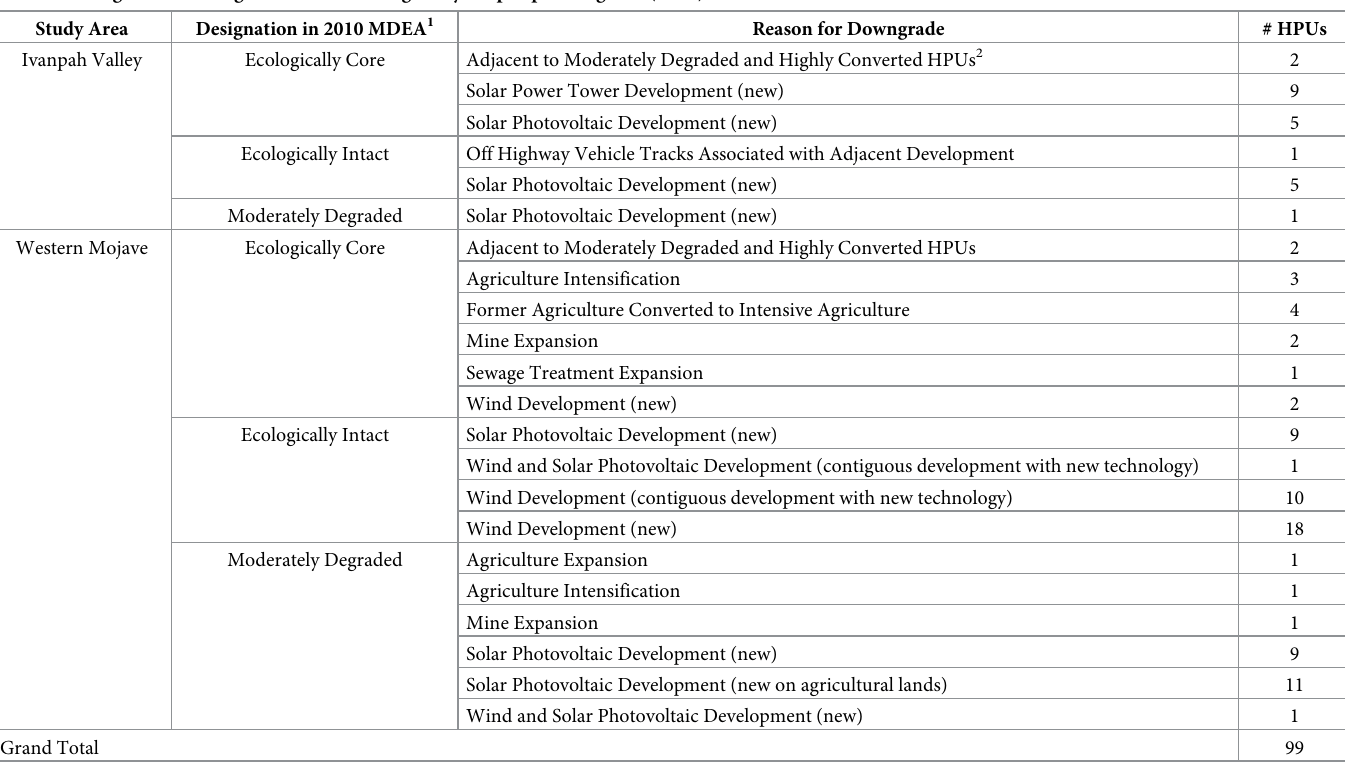
Table 4. Categories of downgrades for each hexagonally-shaped planning unit (HPU). Study